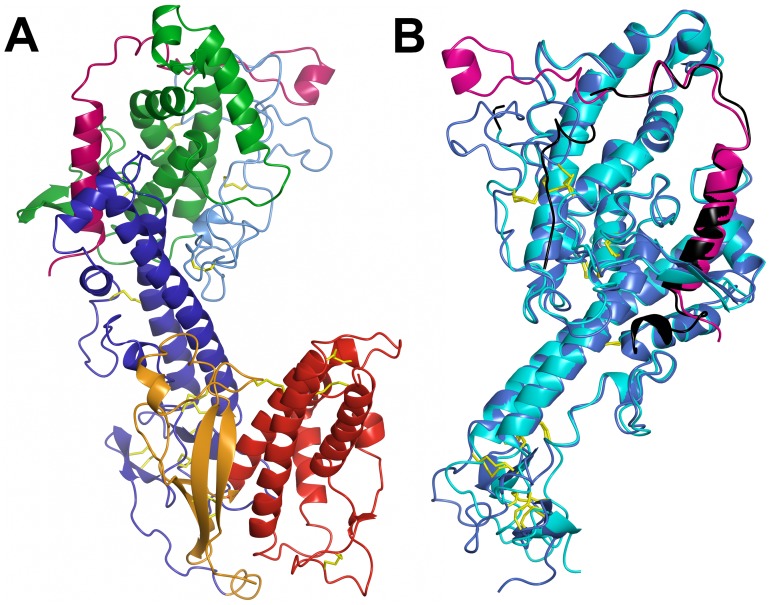
Structure of the DBL1α1-CIDR1γ VarO-Head region.(A) Overall view of the structure of the Head region with subdomains coloured as in Figure 6. (B) Superposition of the DBL1α1 structure determined earlier [27] (in cyan) upon the DBL1α1 domain in the Head structure (in blue). The NTS region is in black for the earlier cleaved structure and in mauve for the Head structure. The view is rotated 180° from (A).